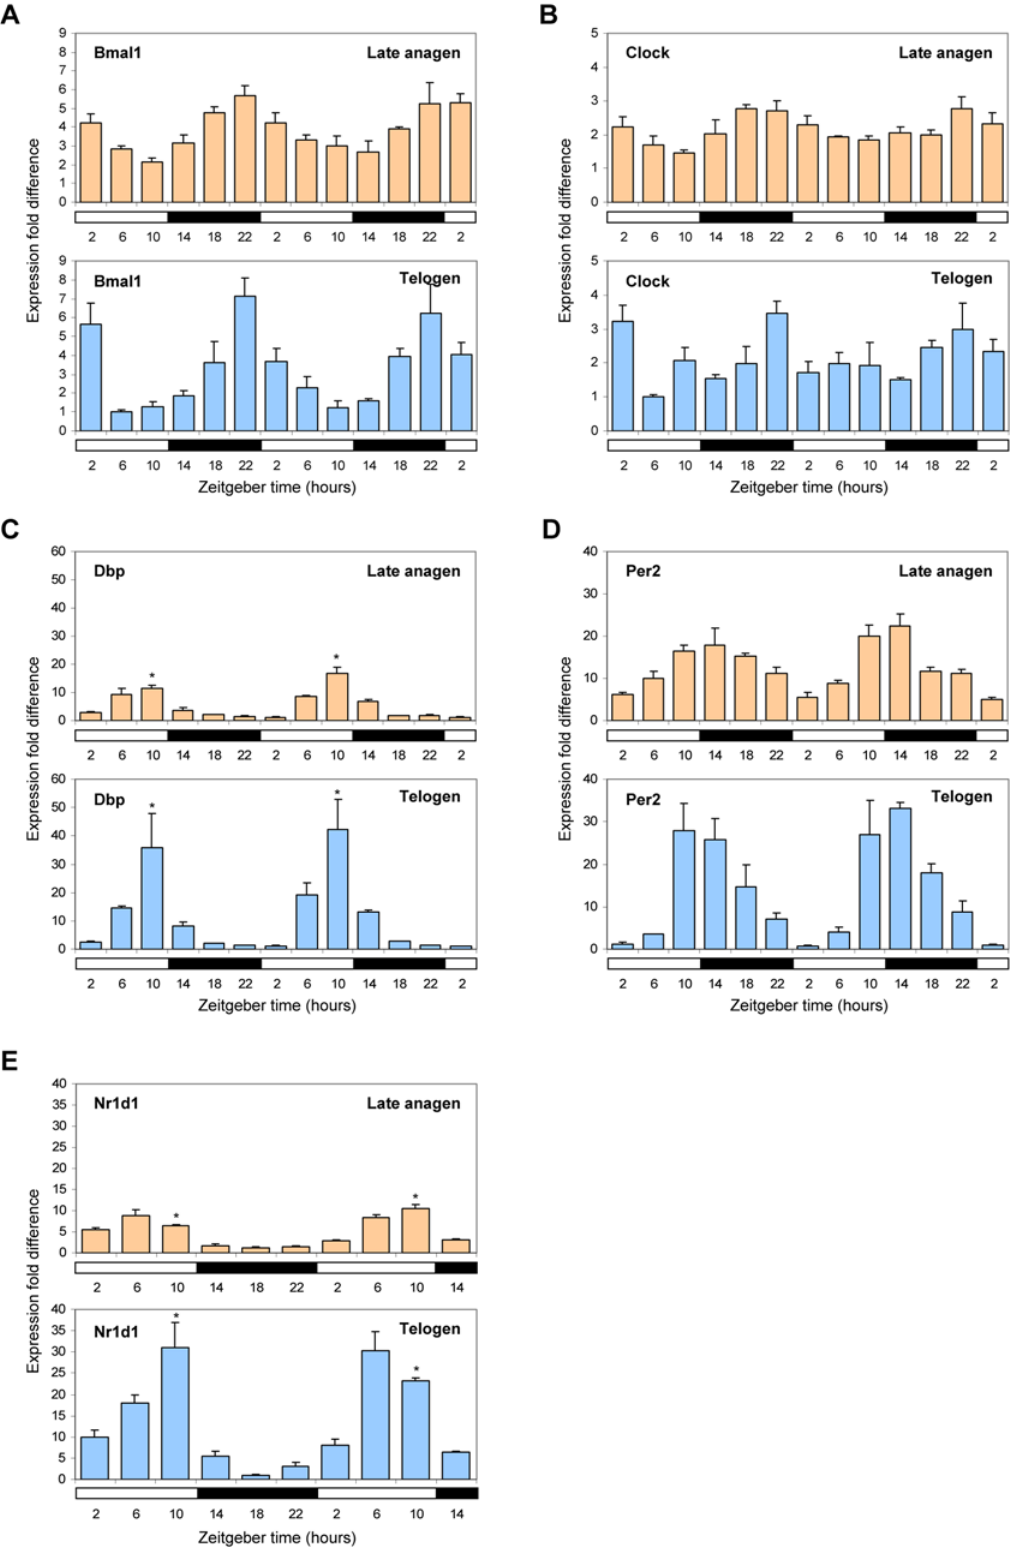
Figure 3. Enhanced circadian expression of CLOCK–regulated genes during telogen. Q-PCR of Bmal1 (A), Clock (B), Dbp (C), Per2 (D), and Nr1d1 (E) in telogen compared to late anagen dorsal skin over the course of 48 hours (open and filled bars along the x-axis denote 12 hours light and dark phases, respectively). Expression is normalized to Gapdh and fold calculated relative to the lowest expression time point for both telogen and late anagen. Each error bar represents the S.E.M. for independent measurements from four mice. Asterisks denote significantly higher ( P , 0.01) expression of Dbp and Nr1d1 at ZT10 in telogen. doi:10.1371/journal.pgen.1000573.g003 PLoS Genetics |